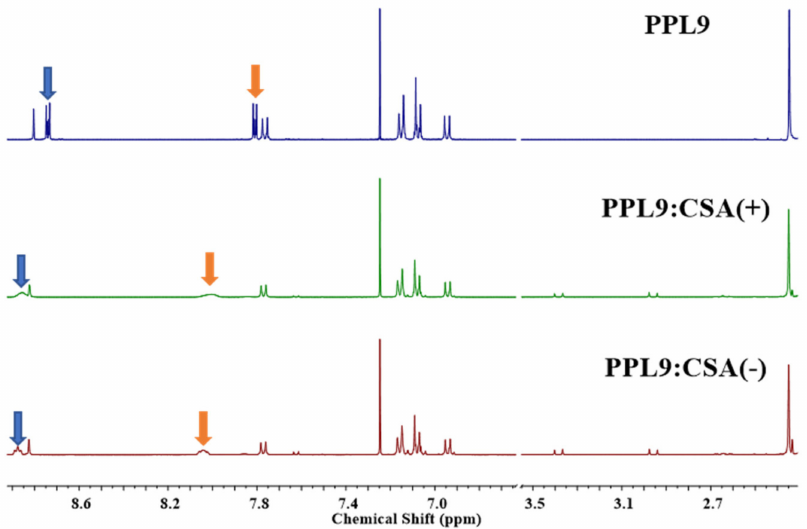
Figure 7. 1 H NMR of PPL9 and PPL9 with CSA( − ) and CSA(+) in 1:1 molar ratio in CDCl 3. Theoretical 1 H NMR spectra of the trans -PPL9 undoped and doped isomer are presented in Figure S8. Protonation of pure pyridine moves the proton NMR chemi- cal shift to the down field (Wiley SpectraBase; http://spectrabase.com/ (accessed